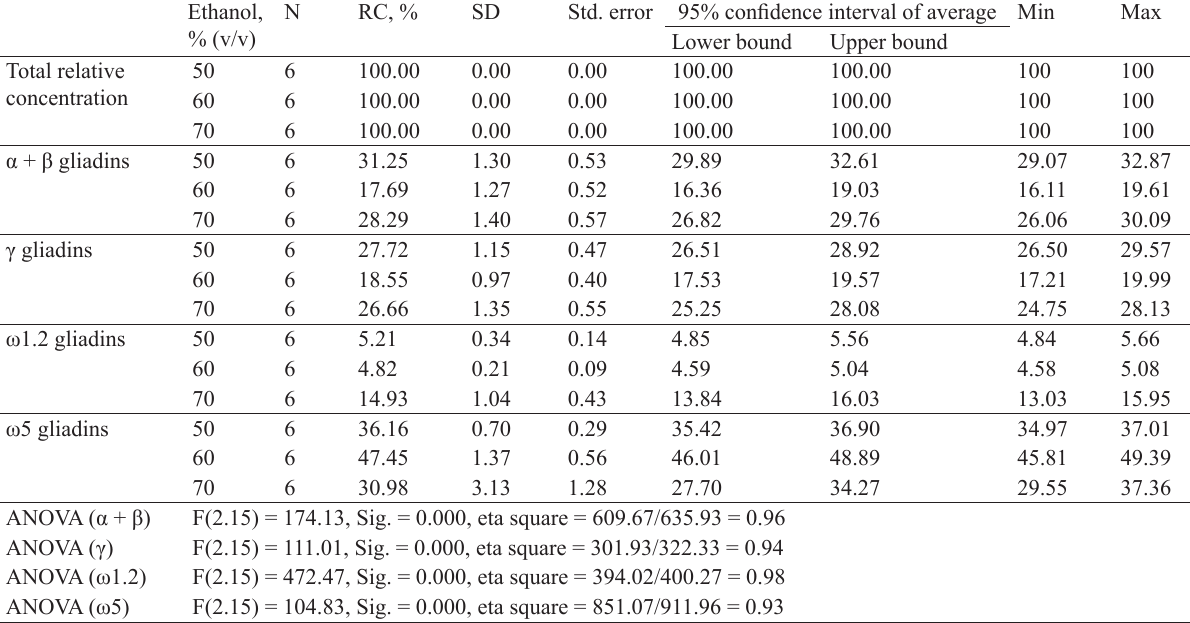
Table 3 Descriptive indicators of the total relative concentration and relative concentration of gliadin fractions (Agilent, CE